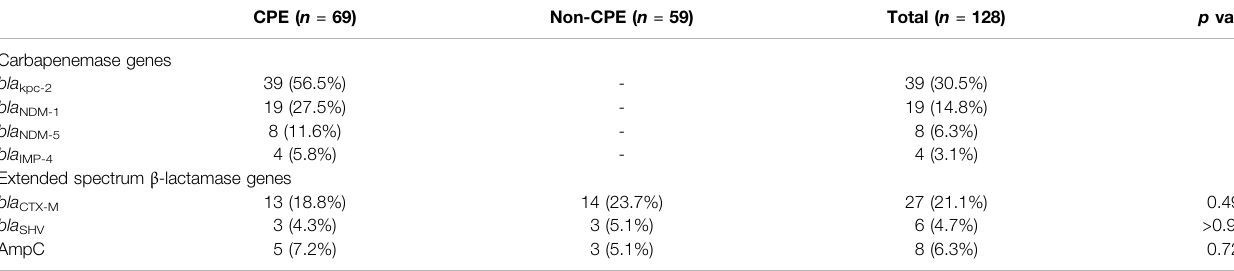
TABLE 1 | Prevalence of carbapenemase, ESBL, and AmpC among CRE.